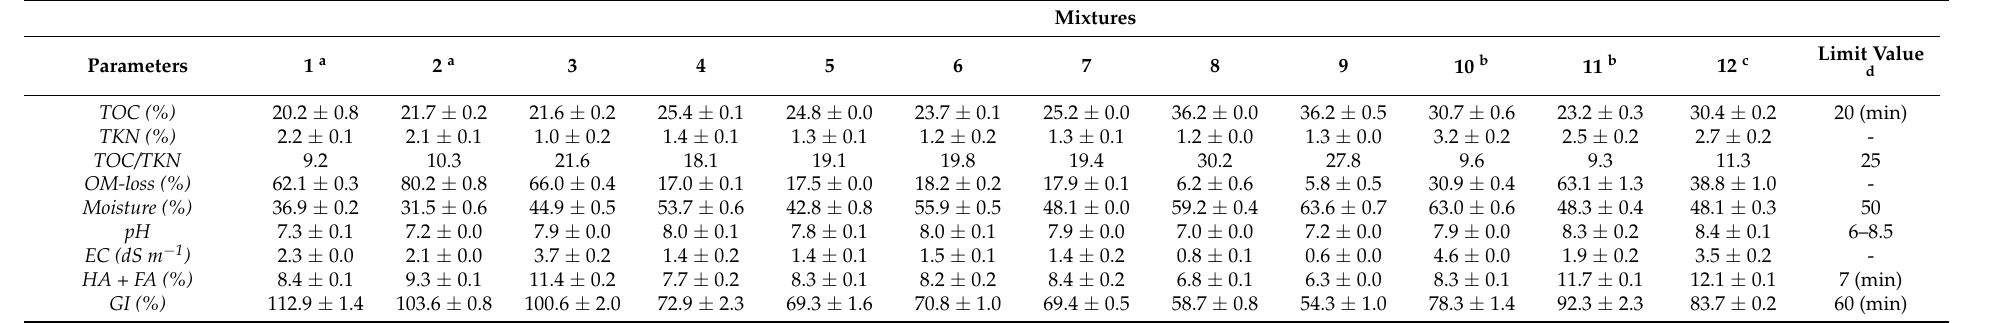
Table 7. Main characteristics of the compost produced from the mixtures studied and limit values for quality compost production [43].